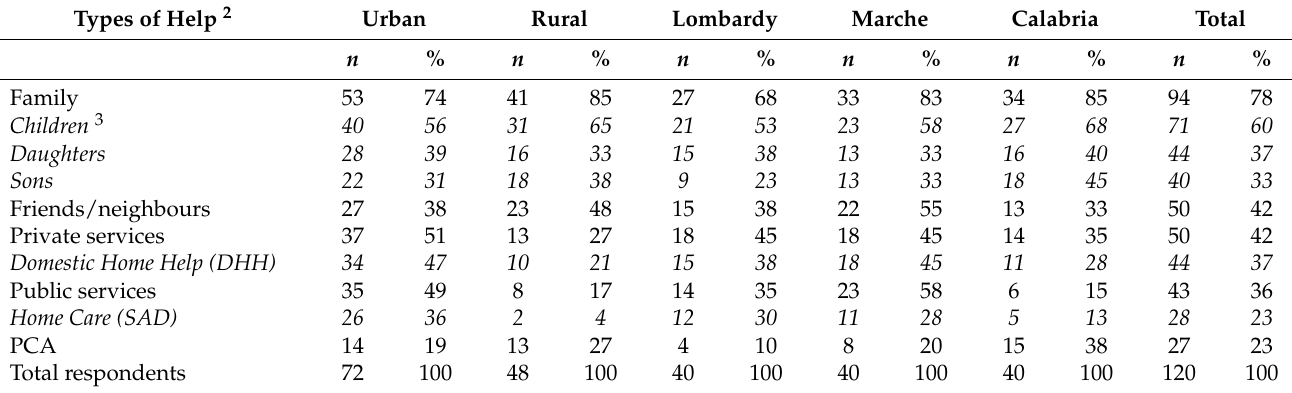
Table 5. Who helps, by sites and regions (at least one type of help) 1